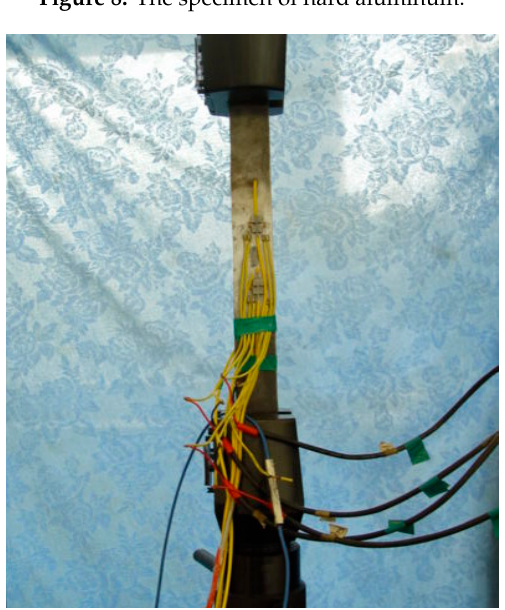
Figure 9. The calibration test.